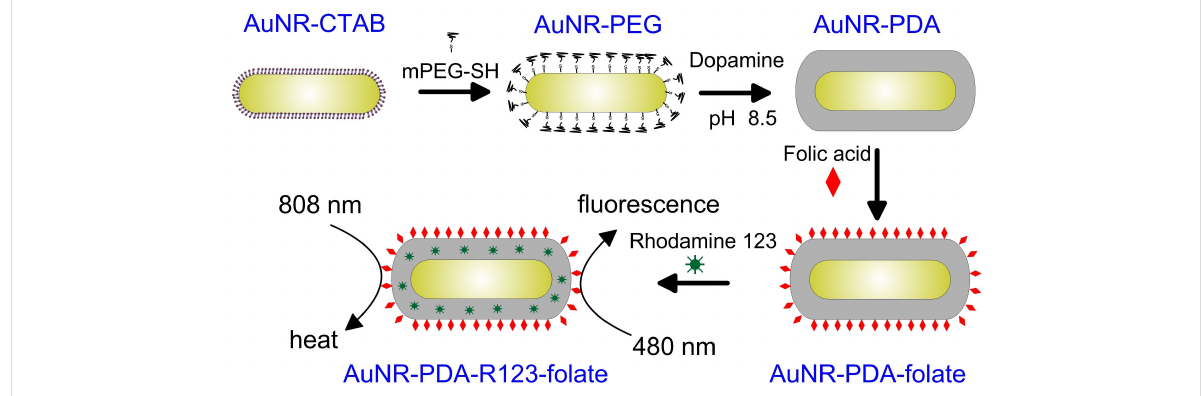
Scheme 1: Schematic illustration of the synthesis, photothermal and fluorescence properties of the AuNR-PDA-R123-folate